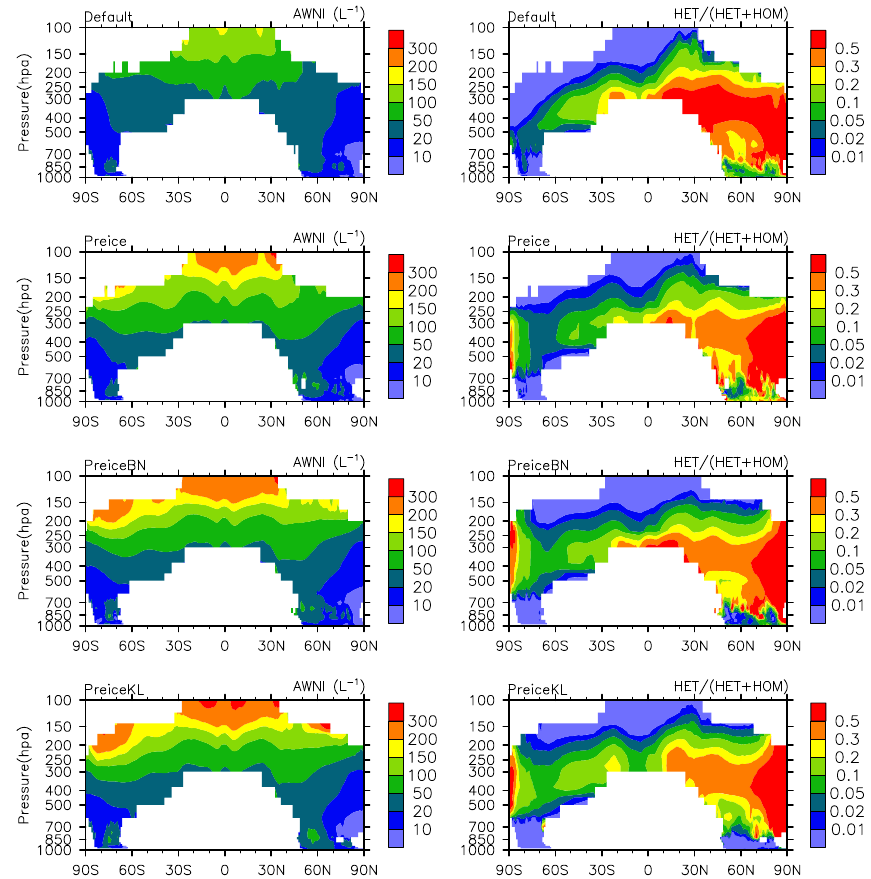
Figure 8. Same as Fig. 7, but for in-cloud ice crystal number concentration (L − 1 , left) and percentage contribution from heterogeneous ice nucleation to total ice crystal number concentration (%, right) from Default, Preice, PreiceBN and PreiceKL